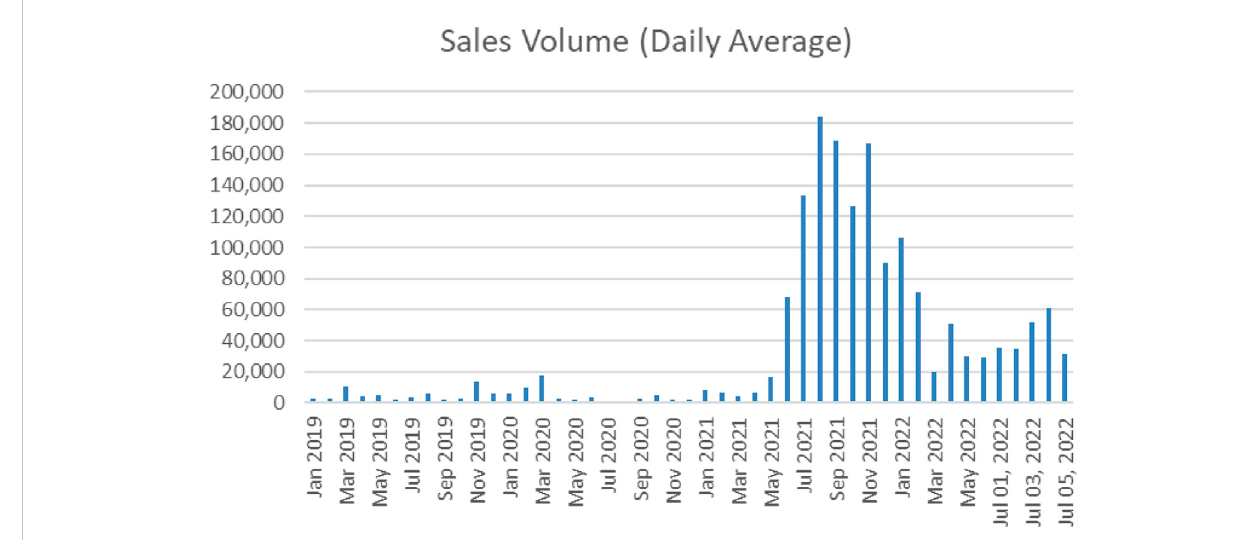
FIGURE 1 Time series patterns of NFT sales.